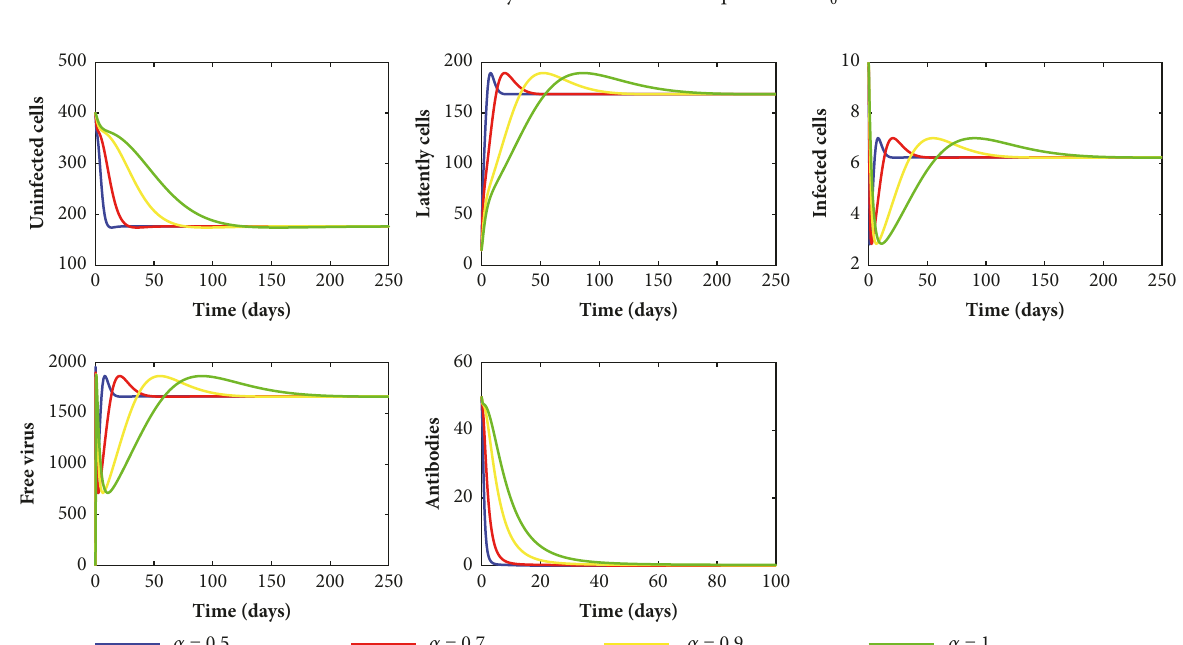
Figure 2: Stability of the infection equilibrium without humoral immunity 𝐸 1